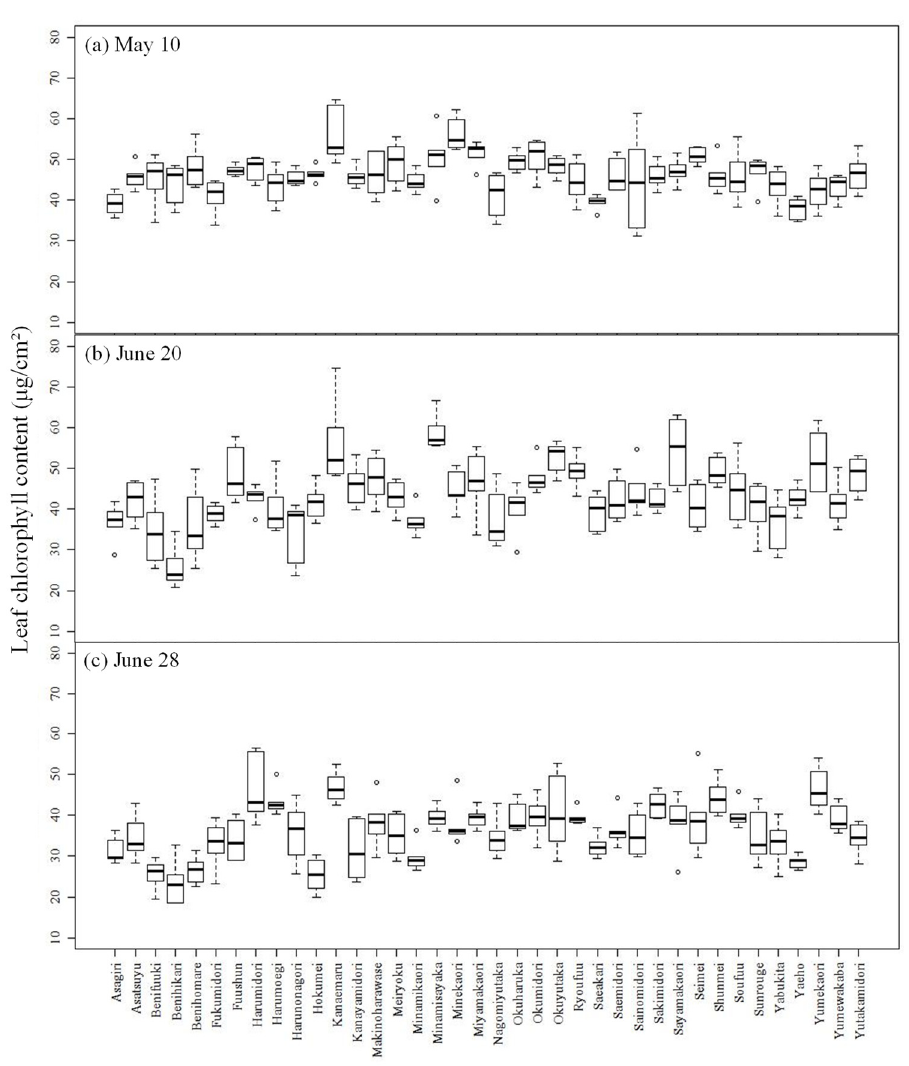
Figure 4. Third-leaf chlorophyll content of tea cultivars grown in this Figure 4. Third ‐ leaf chlorophyll content of tea cultivars grown in this study.